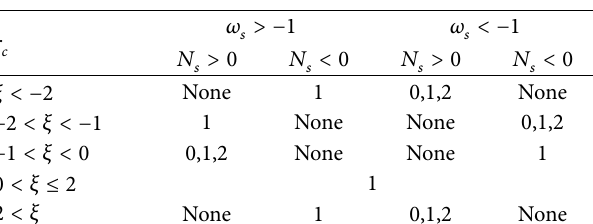
of Equation (23). 𝑐